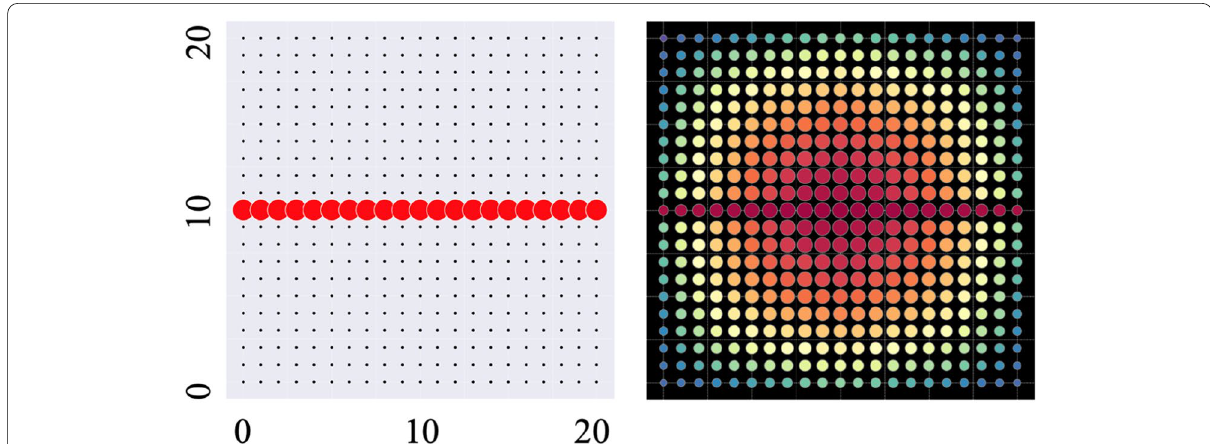
Fig. 8 Spreading the City and Scaling Population into the Two-Dimensional Space